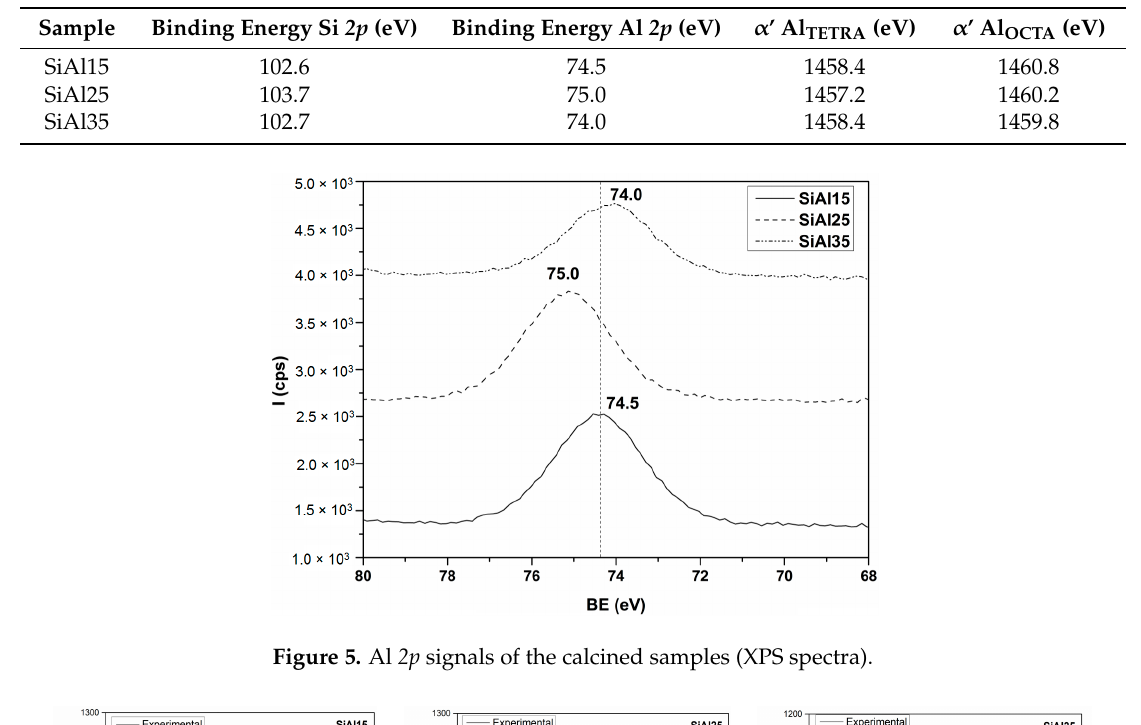
Table 4. XPS (X-ray photoelectron spectroscopy) results of the calcined samples.